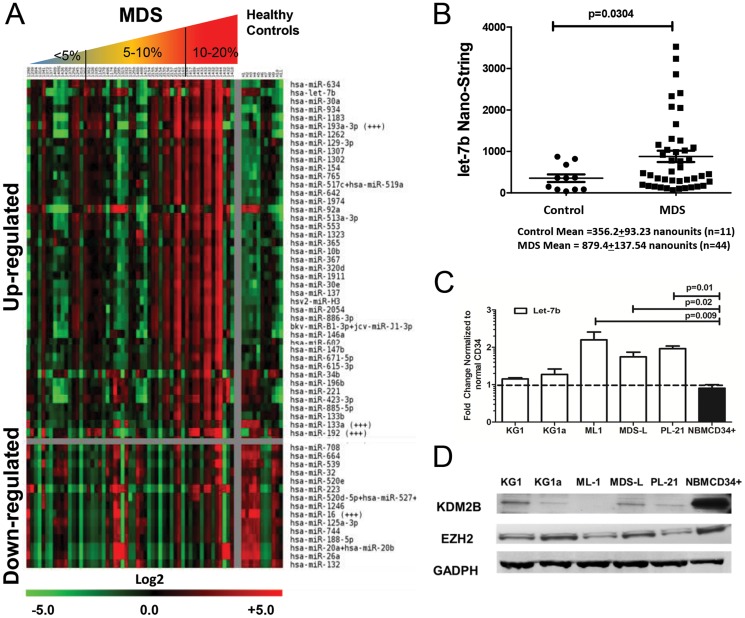
CD34+ marrow cells from MDS patients showing distinct patterns of up-regulated and down-regulated miRs in comparison to healthy controls.
A) Heatmap of the top 43 up-regulated and the top 15 down-regulated miRs in CD34+ marrow cells from healthy controls (n = 11) and patients with MDS (n = 44) ordered by <5% blast (n = 14), 5–10% (n = 17) and 10–20% blasts (n = 13), as determined by nanostring micro-array analysis (two replicates). Expression levels were calculated by averaging the duplicate spots for each miR. MiRs are listed in order of significance (top up-regulated vs. top down-regulated) determined by SAM analysis, displayed is log 2 value. Higher levels of miRs are displayed in red, lower levels in green. B) NanoString Array data of individual samples, shows increased expression of let-7b in MDS (n = 44) compared to CD34+ cells from health controls (n = 11; mean ± SEM = 356.2±93.23 versus 879.4±137.54, p = 0.03 in patients with MDS, Student t-test). C) Let-7b expression (by RQ-PCR) in myeloid cell lines ML-1, PL-21, MDS-L, KG1 and KG1a compared to primary marrow cells from a pool of 6 healthy donors (NBMCD34+)(mean ± SEM of 3 experiments, Fold changes, normalized to expression in healthy donors; Student t-test). D) KDM2b and EZH2 expression (by western blot) in the same cell lines. The lowest levels of KDM2B and EZH2 are seen in ML-1 and PL-21 cells, the cells with the highest levels of let-7b. GADPH served as control (The blots show one of 3 similar experiments).